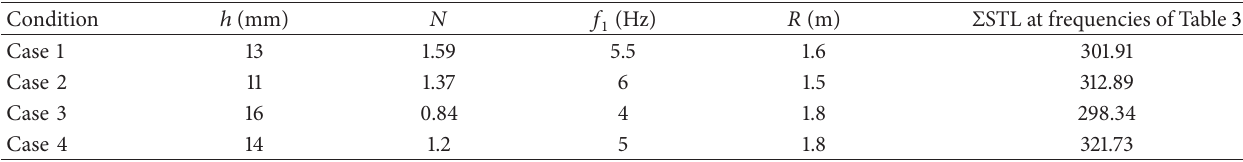
Table 5: Optimized value of FGM